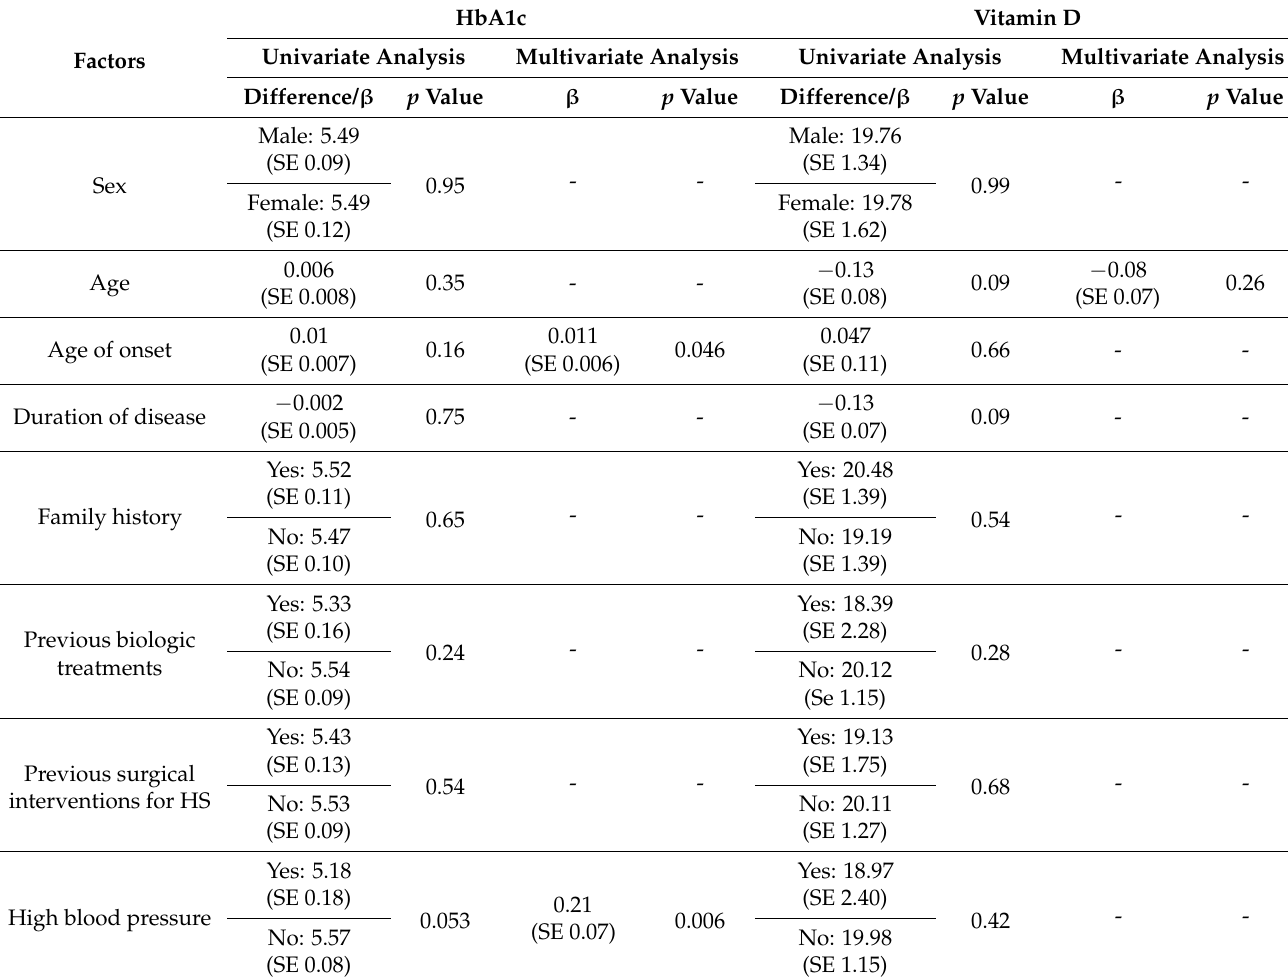
Table 3. Potential clinical and socio-demographic features associated to HbA1c and vitamin D